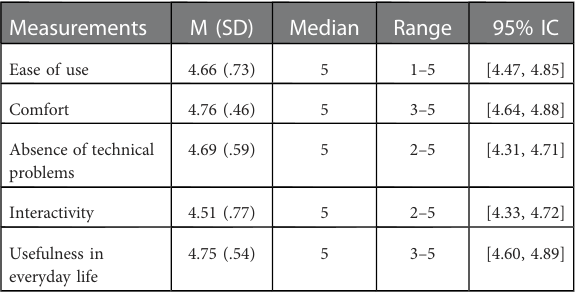
TABLE 2 Descriptive statistics of the variables related to user experience ( n